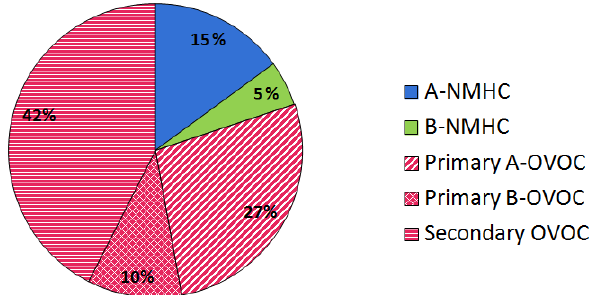
Figure 9. Distribution of the different VOC groups (ANMHC is an- thropogenic NMHCs, blue; BNMHC is biogenic NMHCs, green; OVOC is oxygenated VOCs, pink) calculated from the database used for PMF analysis (same as bottom panel of Fig. S7). The OVOC group is divided into three subclasses to account for their different origins: primary anthropogenic (primary A-OVOC, diago- nal stripes), primary biogenic (primary B-OVOC, grid pattern) and secondary origin from the oxidation of both anthropogenic and bio- genic VOCs (secondary OVOC, horizontal stripes). The partitioning of these OVOCs into the three subclasses is described in Sect.